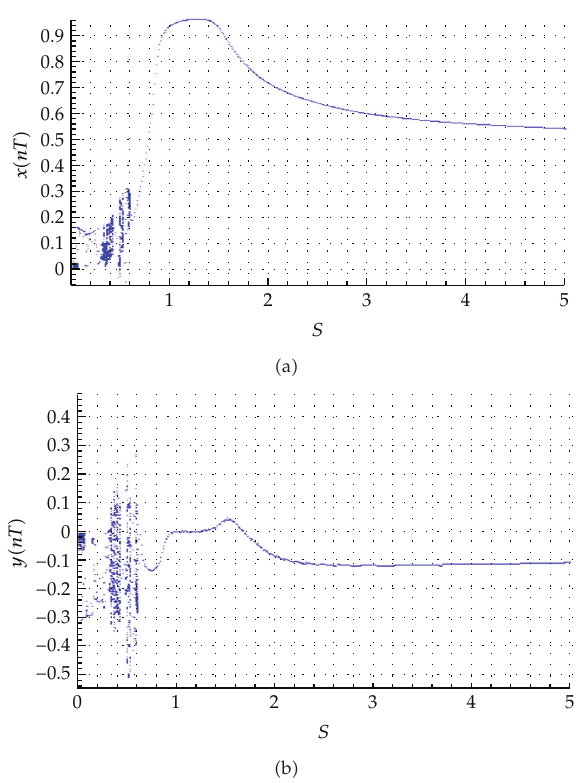
Figure 6: Bifurcation diagram of HSFD rotor-bearing system using dimensionless rotating speed coeffi- cient, s , as bifurcation parameter (cid:2) with rub-impact e ff ect (cid:3) .